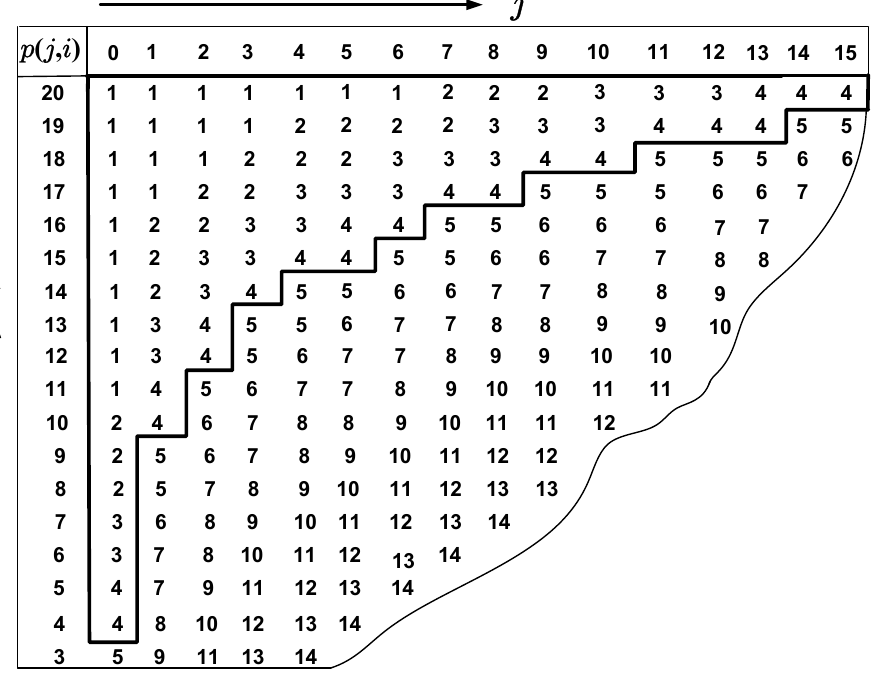
P ( j , i ) (cid:99) on j and i for v = 20; λ = 20; µ = 10; H 1 = 0.7; H 2 = 0.9. Figure A1. Dependence of −(cid:98) log 10 The bold line shows the borders of the set of states ( j , i ) , where P ( j , i ) ≥ 10 − 4 . We define the truncated state space R as an arbitrary subset of S with exception of S itself. The border B of R will be defined as subset of R from which r ( t ) may leave R in one transition. Numerical experiments point out that set of states ( j , i ) , where P ( j , i ) ≥ ε has the same geometrical properties as the truncated state space providing the given relative error ε of performance measures